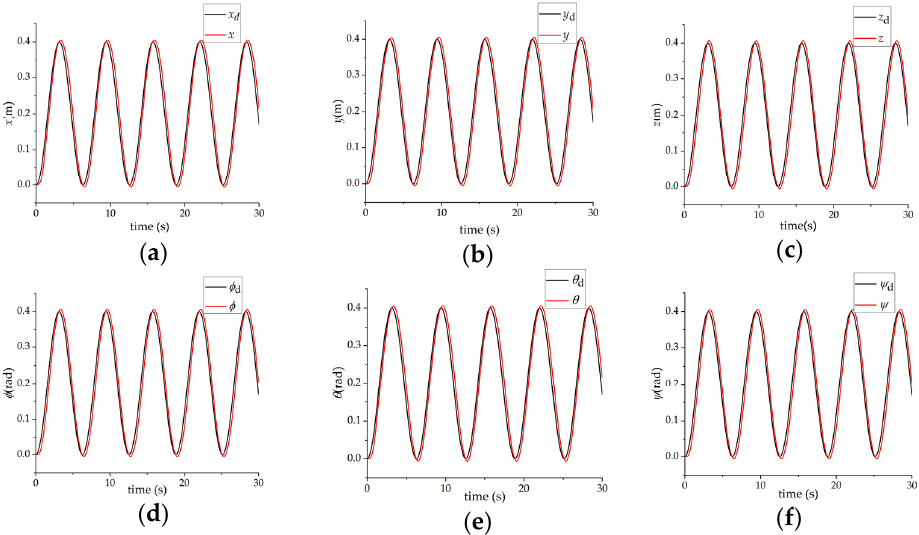
Figure 10. Pose of virtual objects under the two-person collaboration: ( a ) the x component; ( b ) the y component; ( c ) the z component; ( d ) the φ component; ( e ) the θ component; and ( f ) the ψ component.